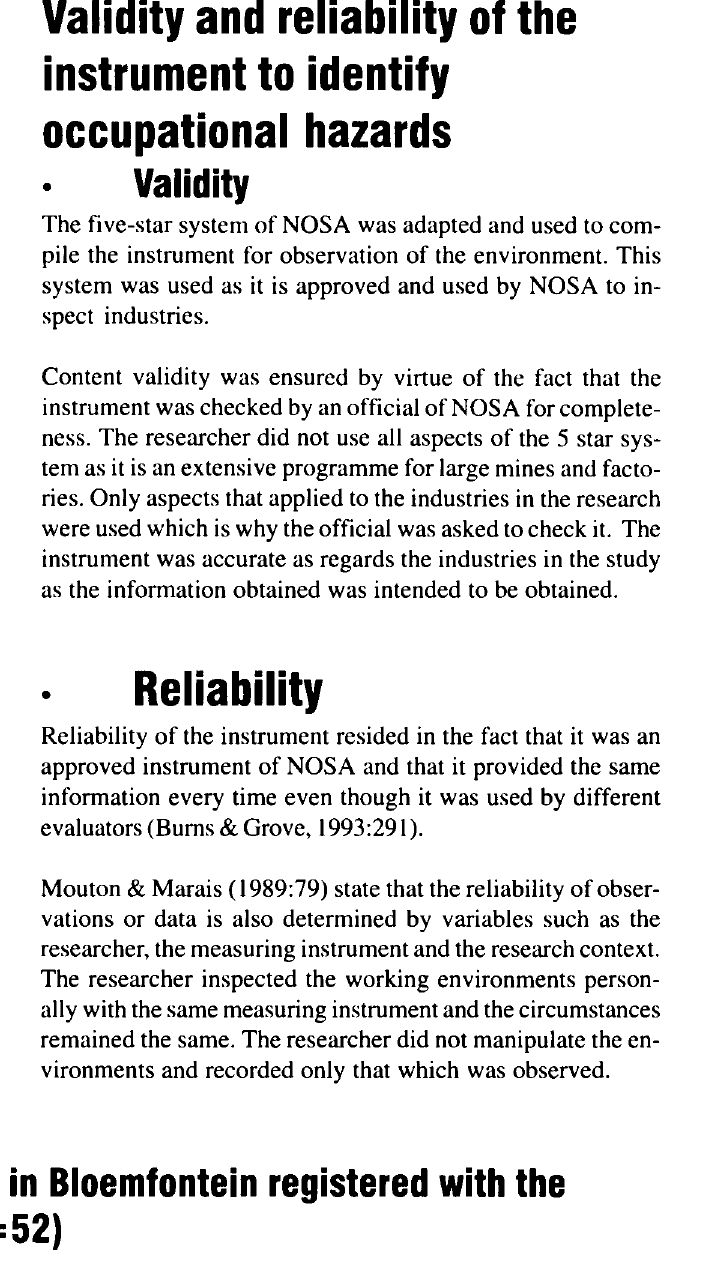
Table 1: Sample framework of industries in Bloemfontein registered with the Chamber of Commerce and Industry